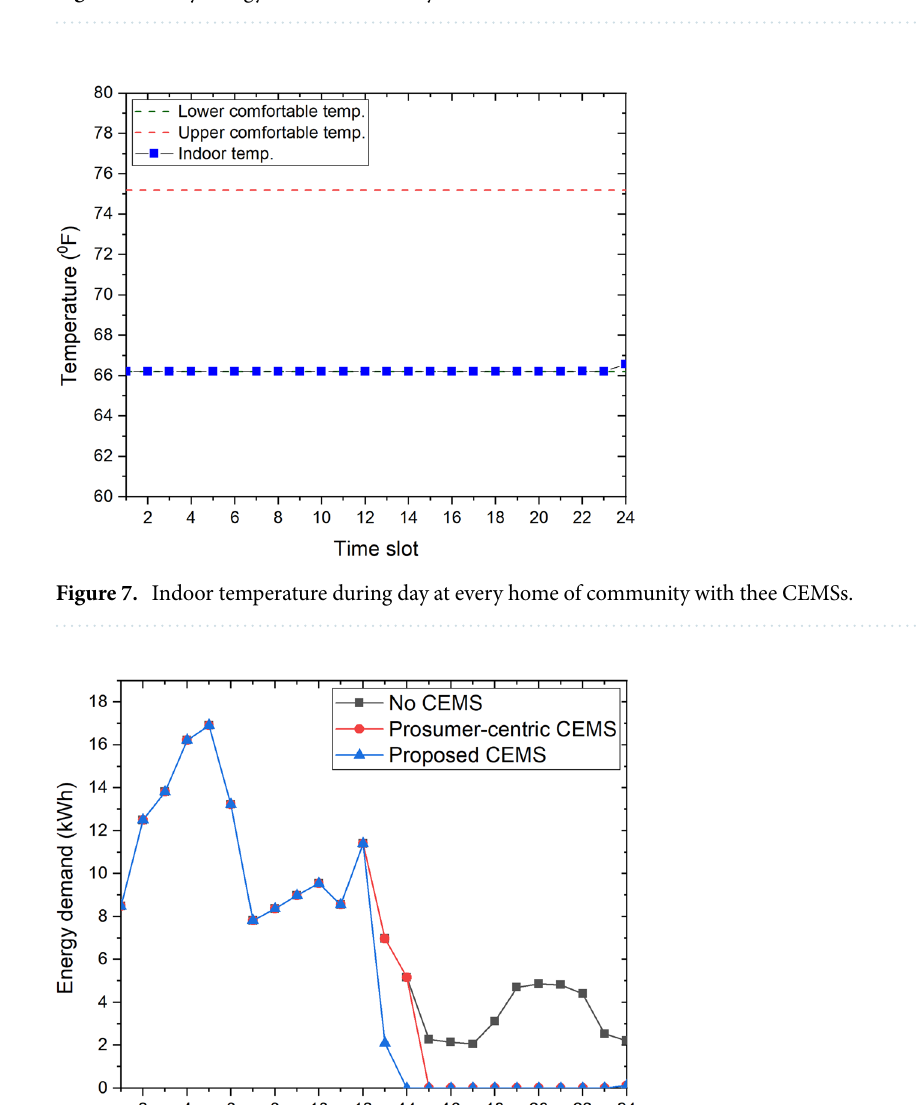
Figure 6. Daily energy cost of community with three CEMSs.